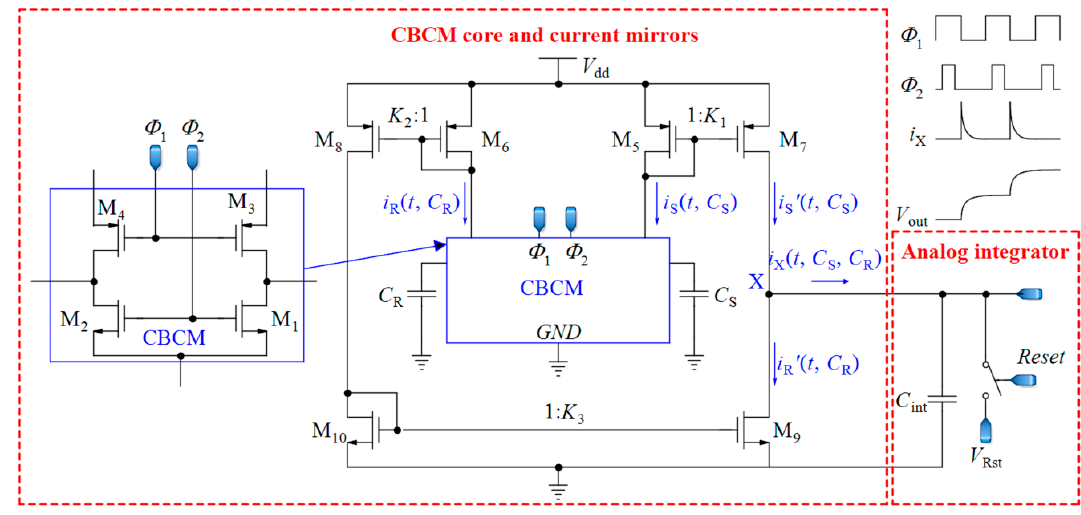
Figure 4. A core-CBCM CVC that subtracts the currents i S and i R before integration (adapted from [58]).